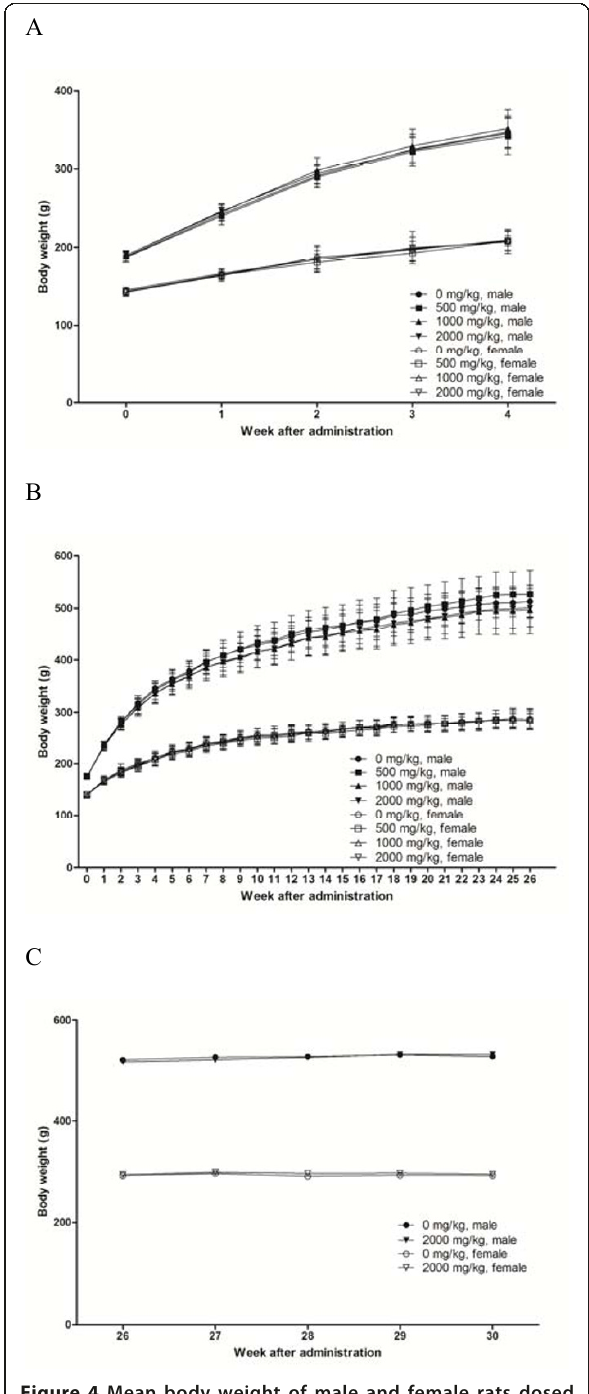
Figure 4 Mean body weight of male and female rats dosed with PM012 . Each data point represents the mean body weight of groups of ten or fifteen animals. A) main group receiving 4 weeks of treatment, B) main group receiving 26 weeks of treatment and C) 4 weeks recovery group. Statistical analysis of the data (Dunnett ’ s test) revealed no significance differences between groups.